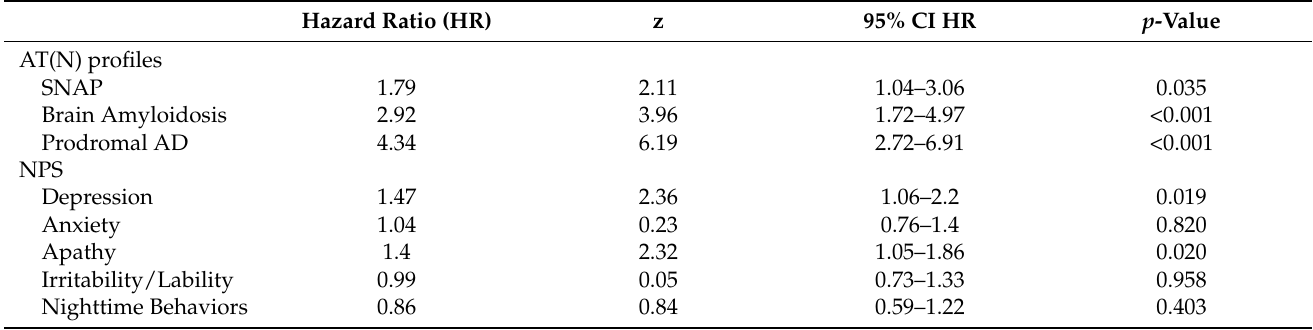
Table 5. Cox regression analysis for AT(N) profiles, NPSs and adjusting